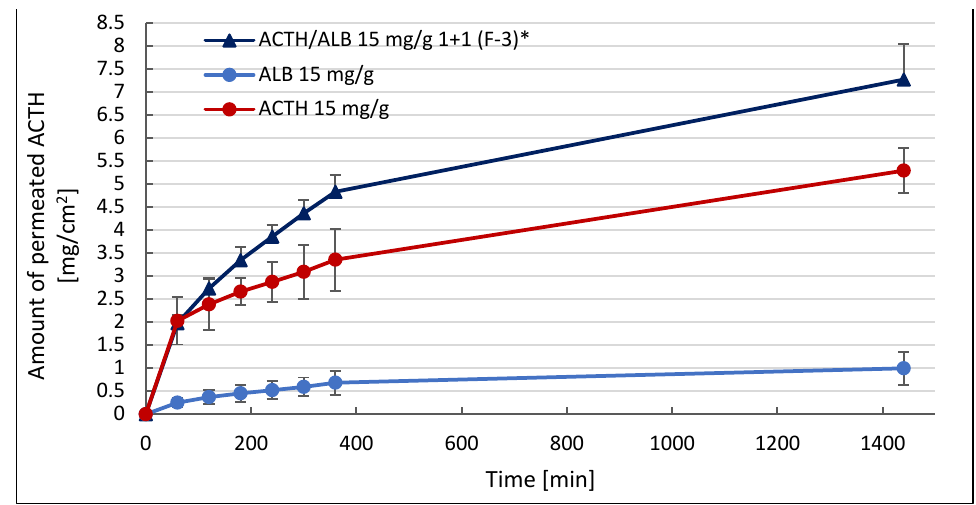
Figure 3. Profiles of ACTH permeation through porcine skin in the presence of albumin in a 1:1 ratio at concentrations of 15 mg/g ACTH and albumin, from a hydrogel containing only albumin-ALB 15 mg/g and from a hydrogel containing only ACTH 15 mg/g (* p < 0.05 refer to hydrogel containing only ACTH 15 mg/g). Table 5. The regression coefficients and average permeation rate of ACTH through the porcine skin in presence of albumin in ratio 1:1 at concentration 15 mg/g ACTH and albumin, from hydrogel containing albumin–ALB 15 mg/g and from hydrogel containing ACTH 15 mg/g (* p < 0.05 refer to hydrogel containing only ACTH 15 mg/g). Formulation